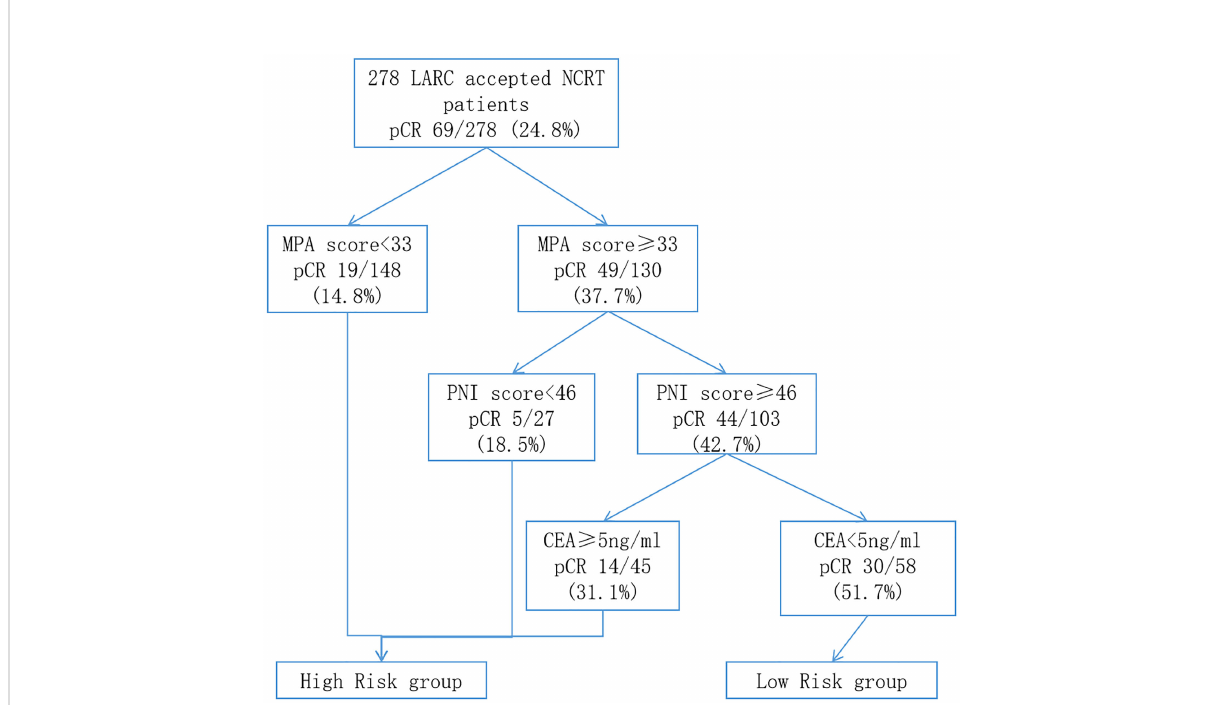
FIGURE 7 Classi fi cation tree identifying the groups at high- and low-risk for pCR of patients with LARC after NCRT. pCR, pathology complete response; LARC, locally advanced rectal cancer; NCRT,